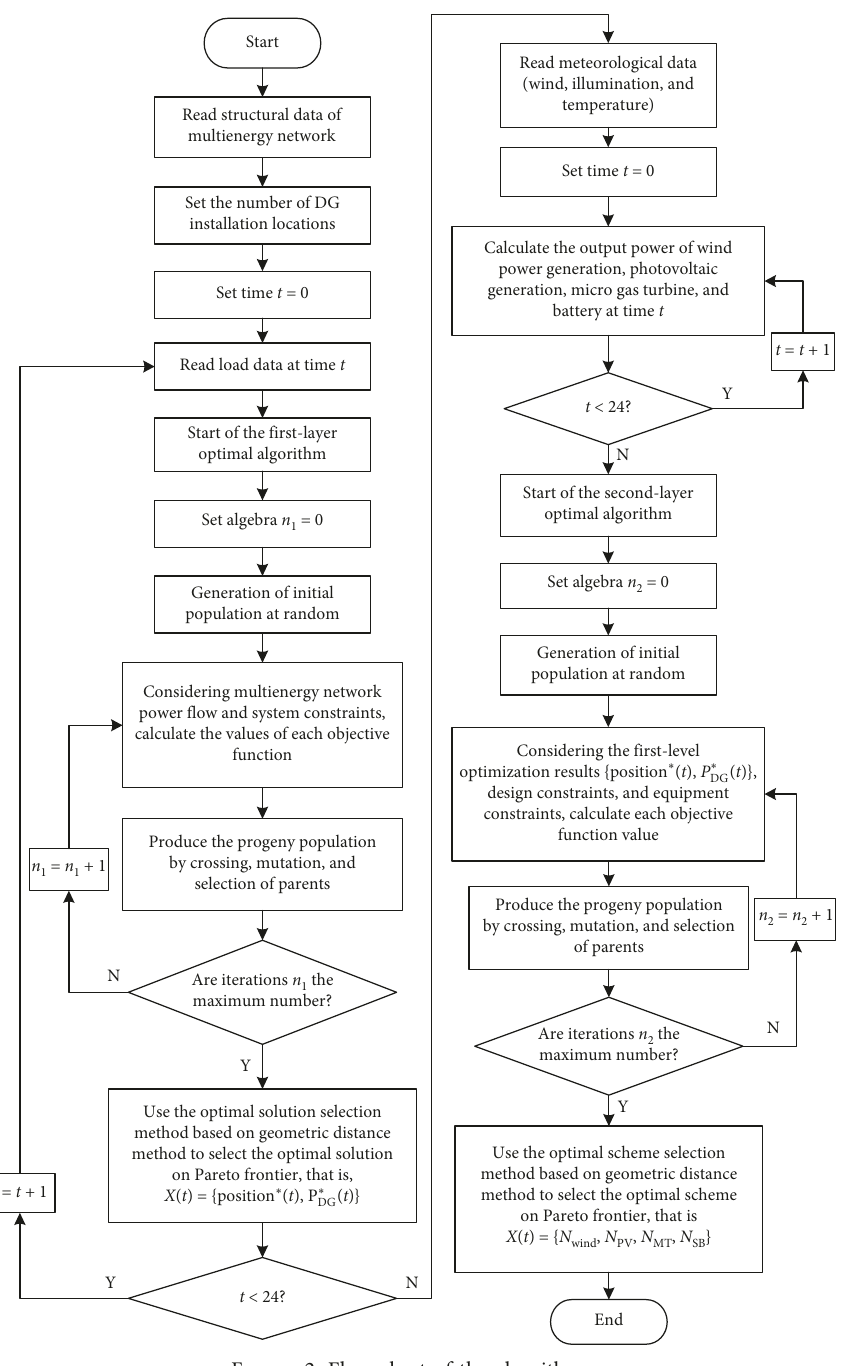
Figure 2: Flow chart of the